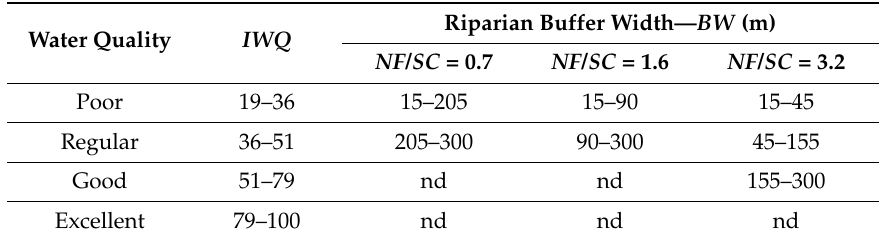
Table 5. Riparian buffer width ( BW ), native forest/sugar cane ratio ( NF/SC ) and related water quality ( IWQ ), as predicted by Equation (3) for three constant values of NF/SC